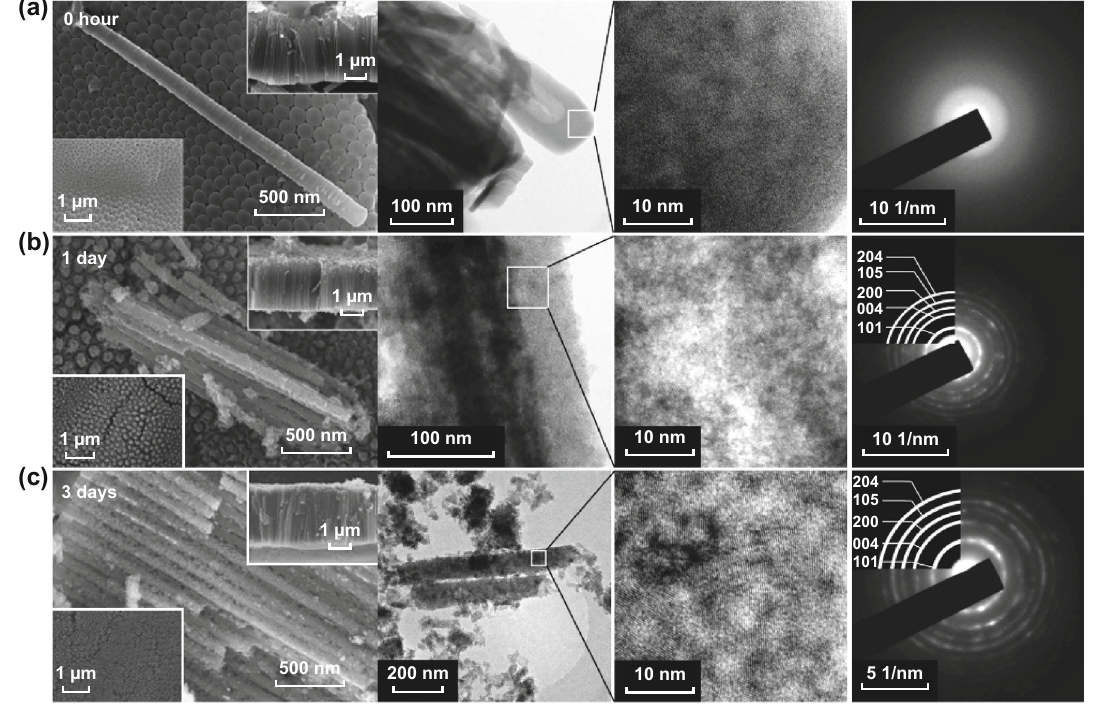
Fig. 10 SEM, HRTEM and SAED images of the a as-anodized TNTs, b after water soaking for 1 day, and c after water soaking for 3 days